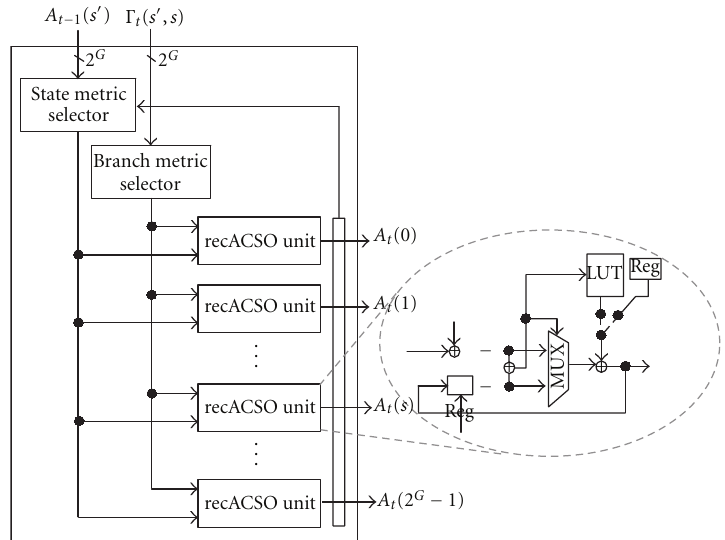
Figure 5: State metric calculation